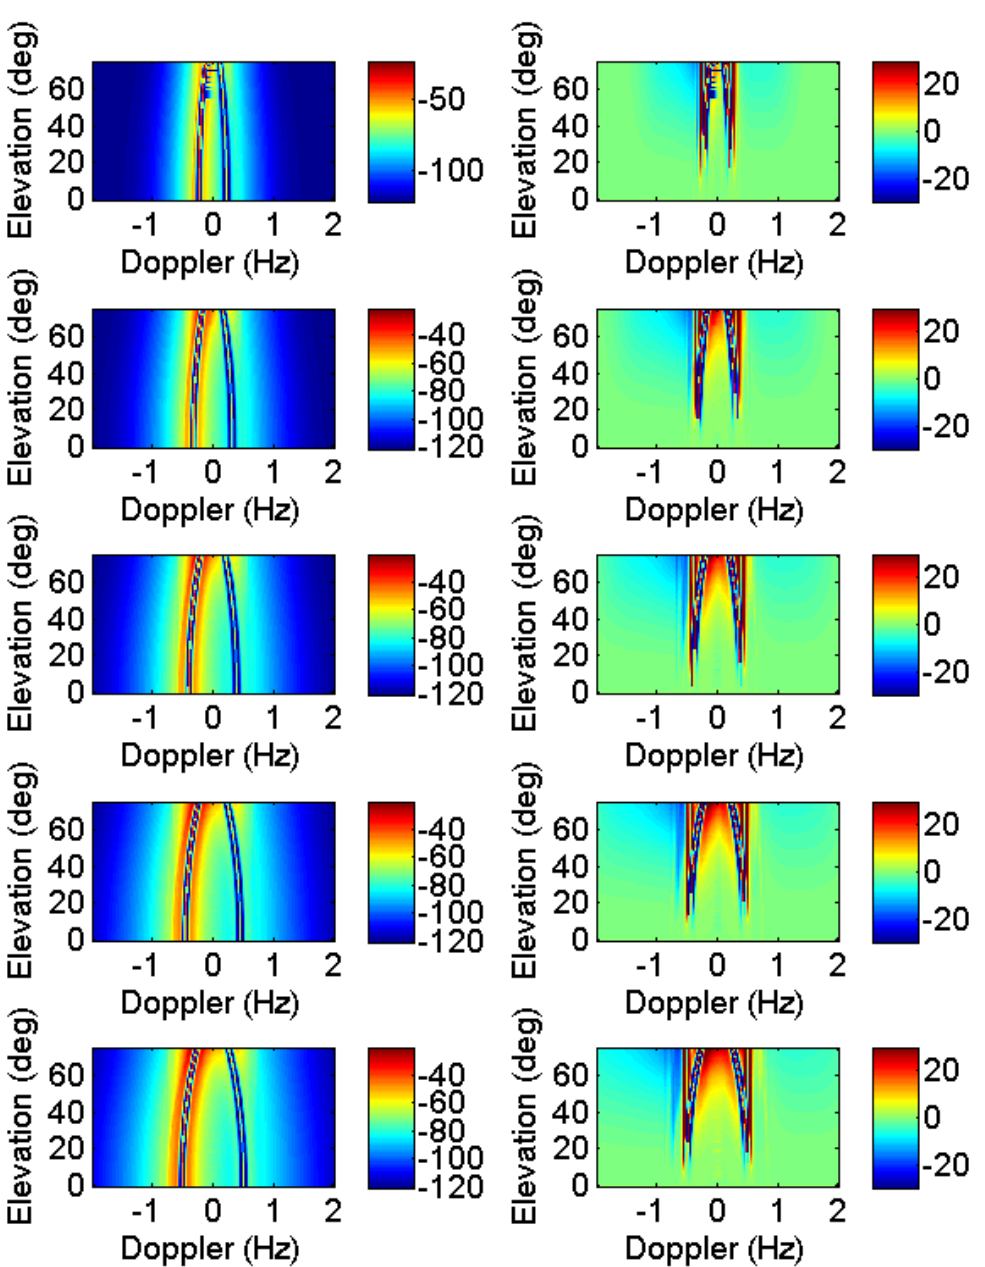
Figure 14. Doppler spectra as a function of elevation at radar frequencies 5, 10. 15, 20, and 25 MHz ( left column ), and the same spectra after subtracting (in dB) the grazing incidence spectrum ( right column ). All colour bars on the left panels measure power spectral density in dB/Hz, while those on the right panels measure dB since they describe ratios.